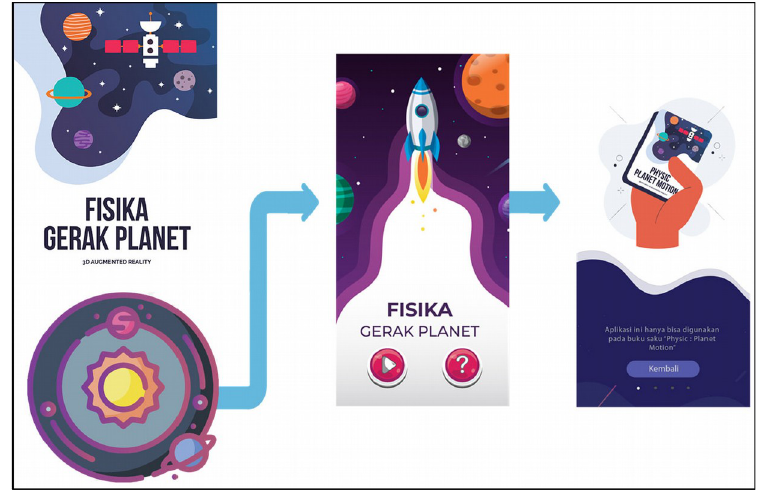
Figure 7. Interface design of augmented